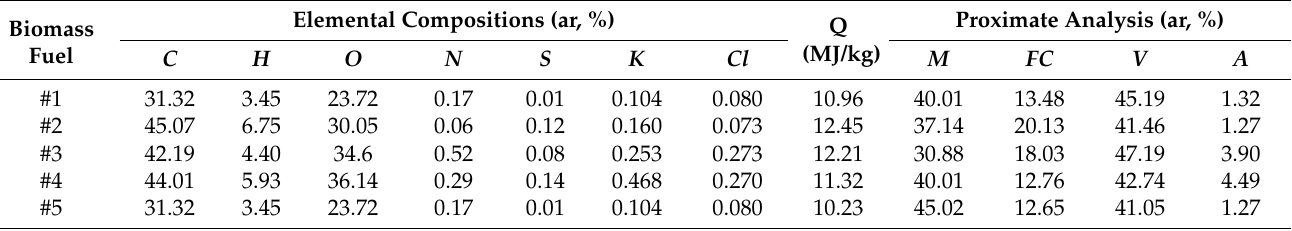
Table 3. Proximate and Elemental Analysis Results of Five Biomass